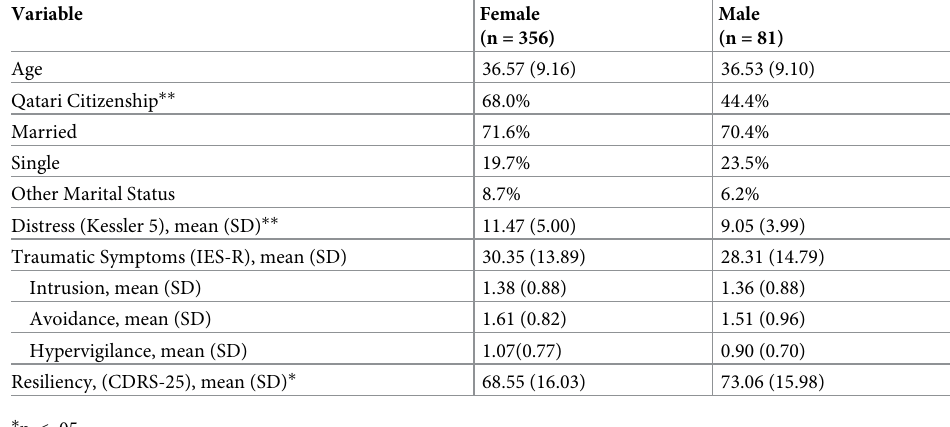
Table 3. Bivariate analysis by sex (n = 437). Bivariate analysis by sex with sample size 437 (356 female; 81 male) showing prevalence of distress, traumatic symptoms, and resiliency. Variable